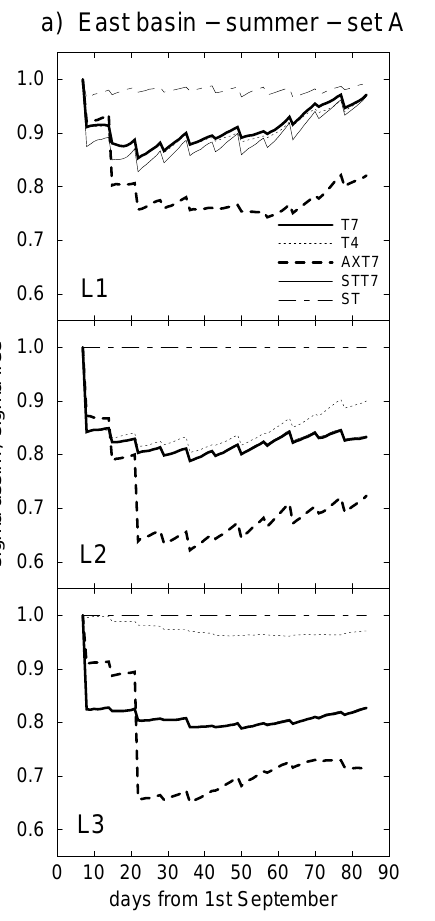
sentially coincides with T7 in all layers (Fig. 8a), as is